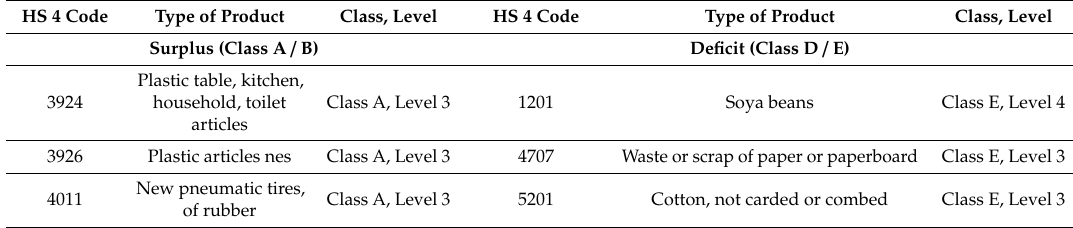
Table 2. Import–export di ff erence class information of some high-level products (Level >